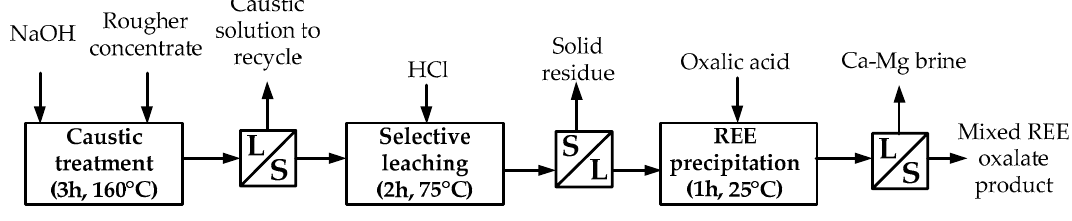
Figure 8. Process proposed for REE flotation concentrates.